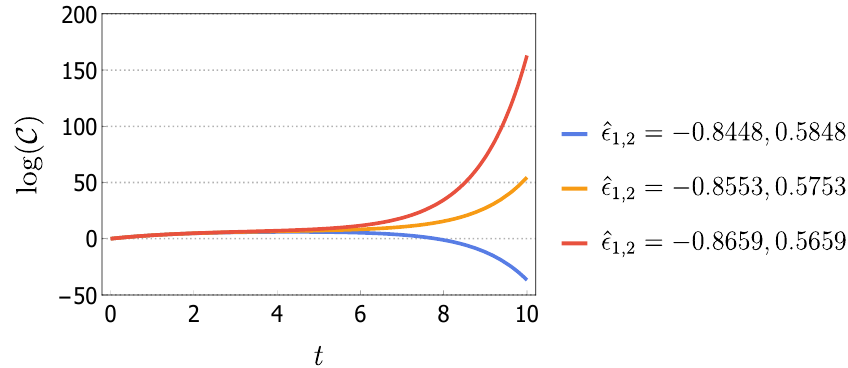
Figure 9 . Evolution of Complexity for a K = 2 parameter system with a variation of eigenvalue of Encoder-Dataset tensor A ∞ in a non-chaotic regime.